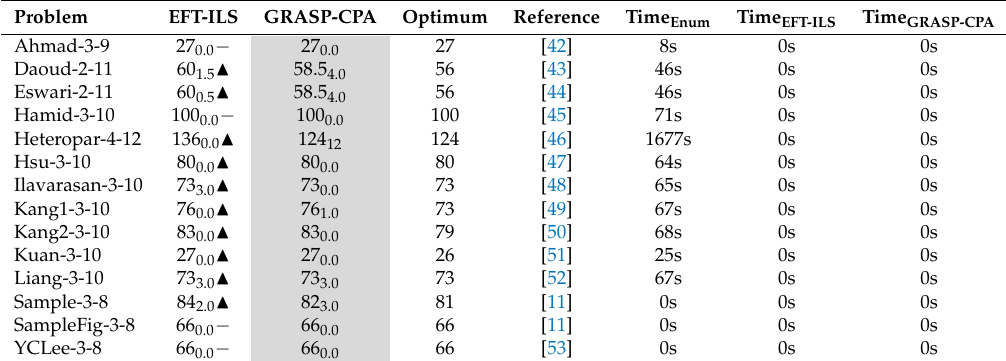
Table 8. Small synthetic benchmark instances median and IQR of EFT-ILS and GRASP-CPA over 100 independent runs. Light gray emphasizes the best results.